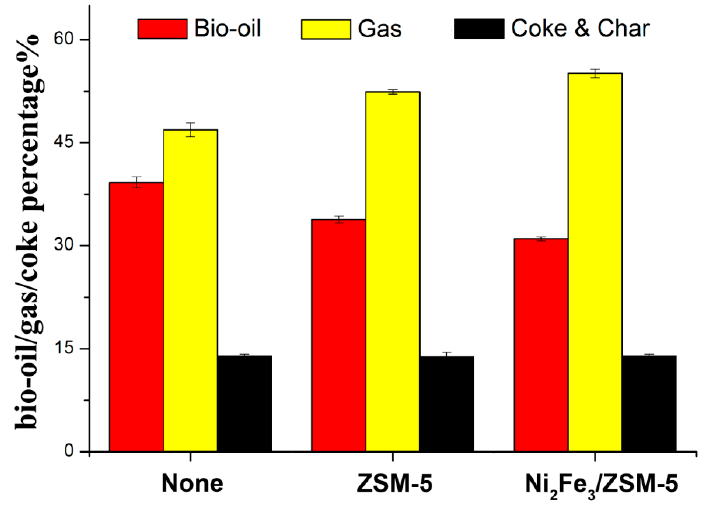
Figure 5. Bio-oil, gas, and char/coke yields from pyrolysis of cellulose without/with the ZSM-5 and Ni 2 Fe 3 / ZSM-5 catalysts (heterogeneous catalysis) and None: without Ni 2 Fe 3 /ZSM-5 catalysts (heterogeneous catalysis) and None: without catalysts.